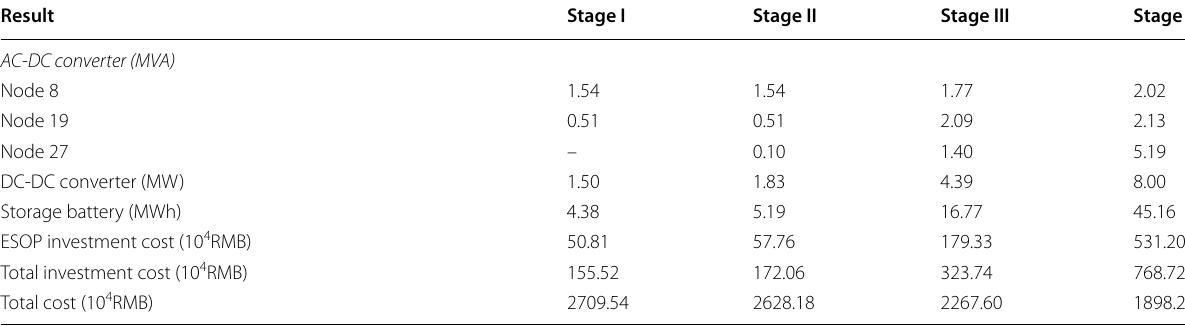
Table 10 Multi-stage planning results in Case